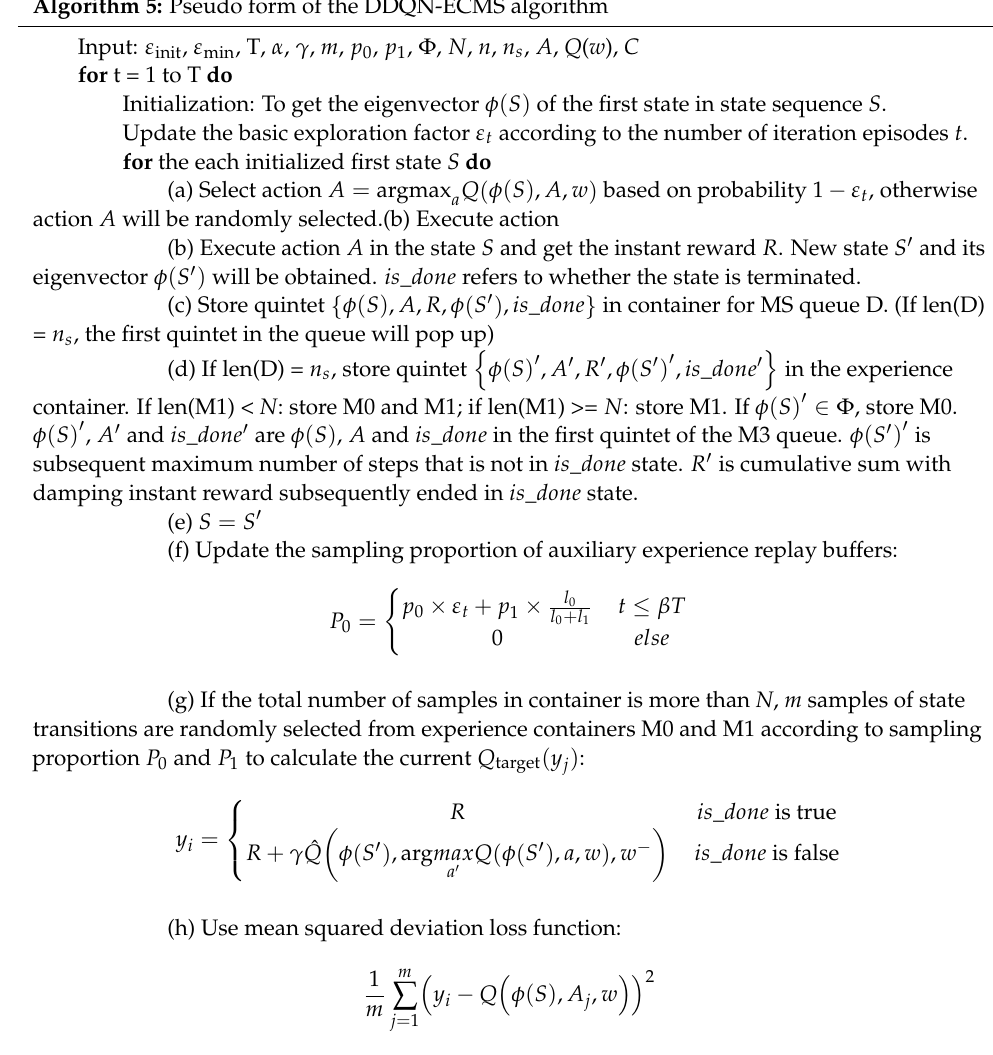
Algorithm 5: Pseudo form of the DDQN-ECMS